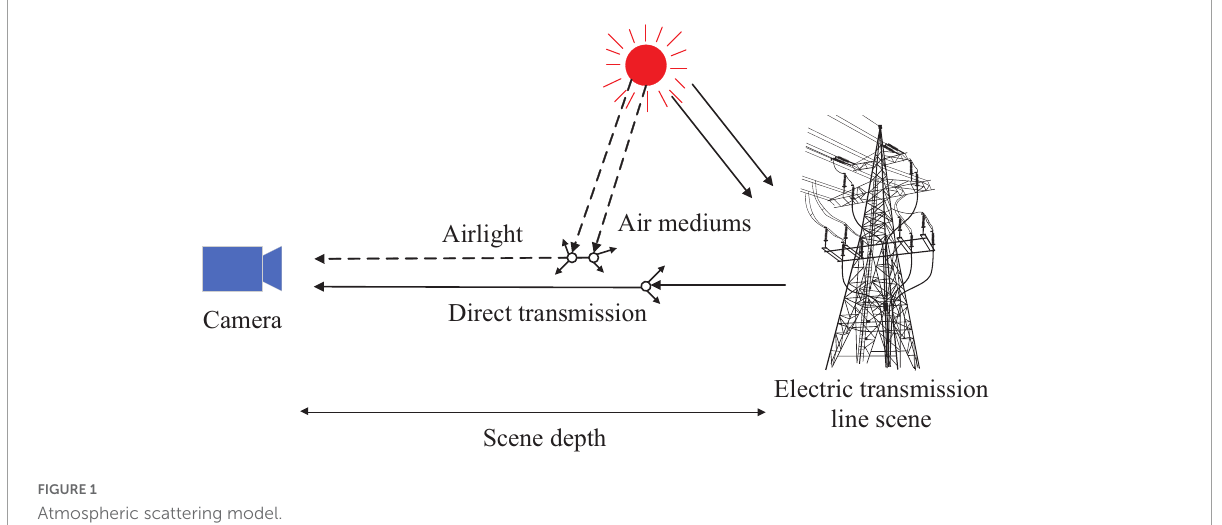
FIGURE1 Atmospheric scattering